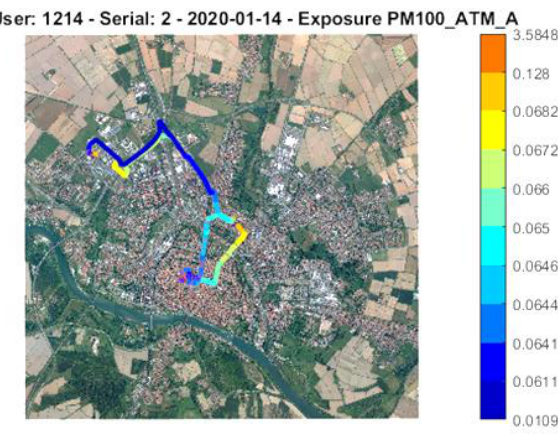
Figure 20. Exposure calculated at any location, measured in micrograms of PM 10